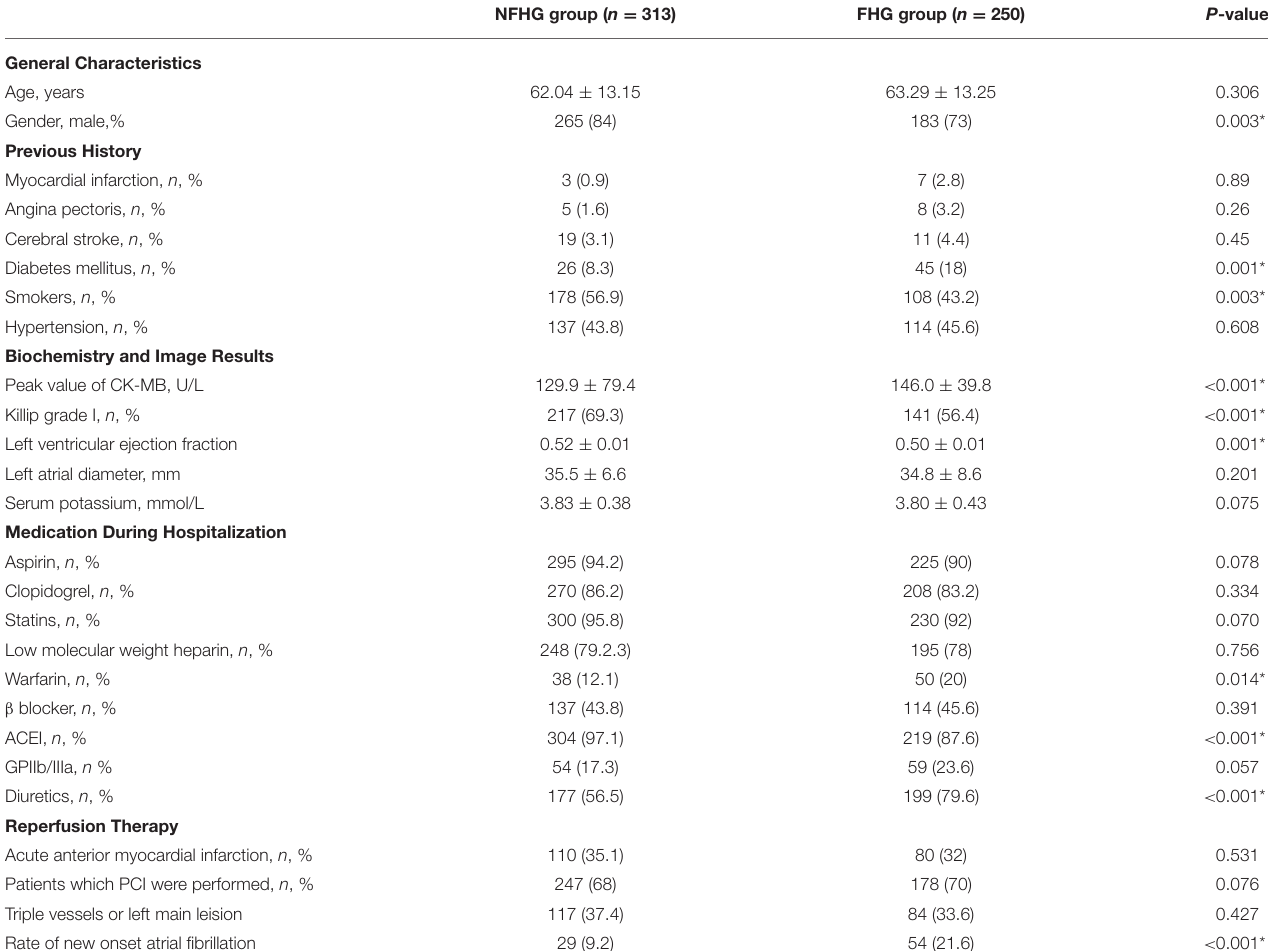
TABLE 1 | Baseline characteristics of patients in NFHG group vs. FHG group.